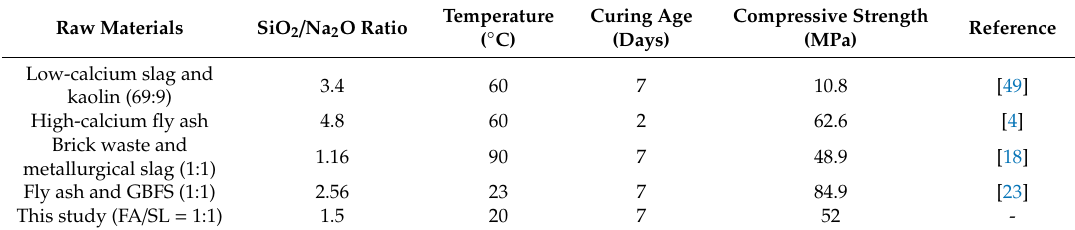
Table 3. Comparison of compressive strength of alkali-activated materials with references.